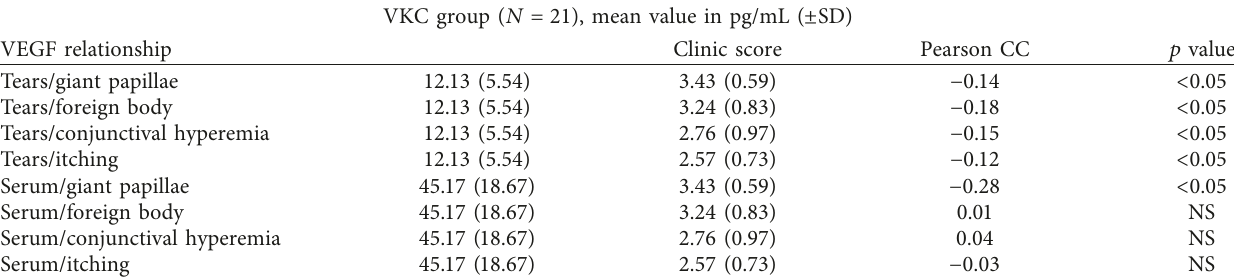
Table 3: Pearson correlation coefficient (CC) results (parametric test) (statistical significance was set at p < 0 .